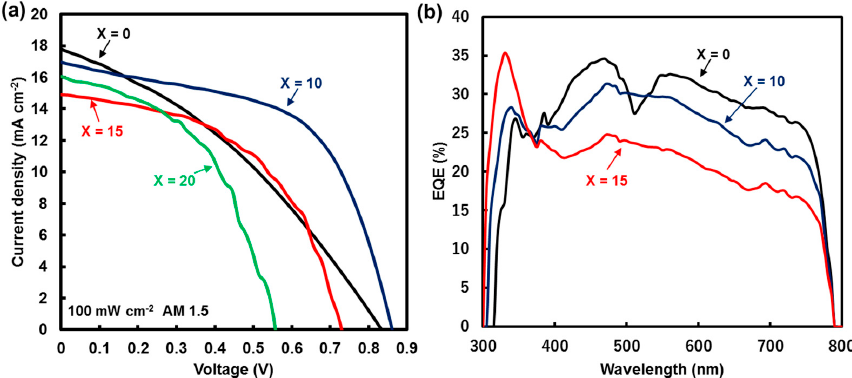
Figure 2. ( a ) J–V characteristics and ( b ) External quantum efficiency (EQE) spectra of the CH 3 NH 3 PbI (MAPbI 3 )/dipeptidylpeptidase (DPPS) ( X mg mL − 1 ) cells.